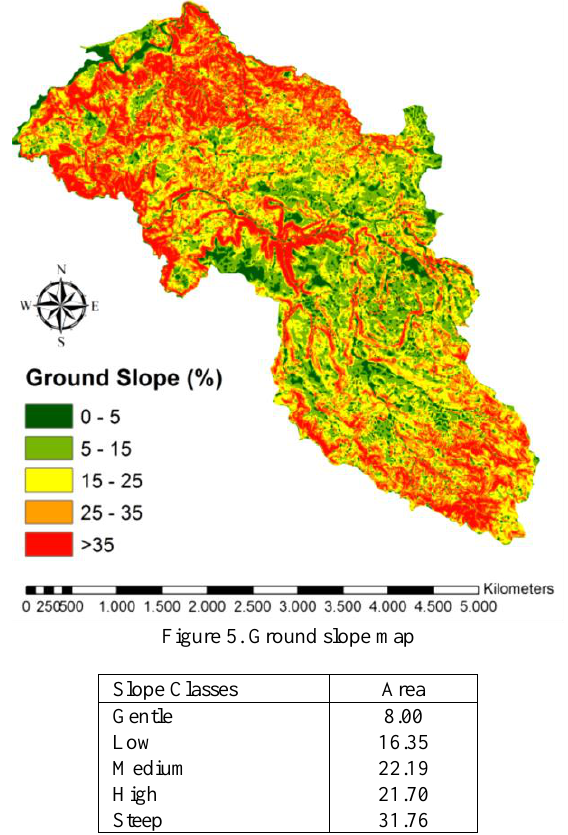
Table 8. Areal distribution (%) of slope classes